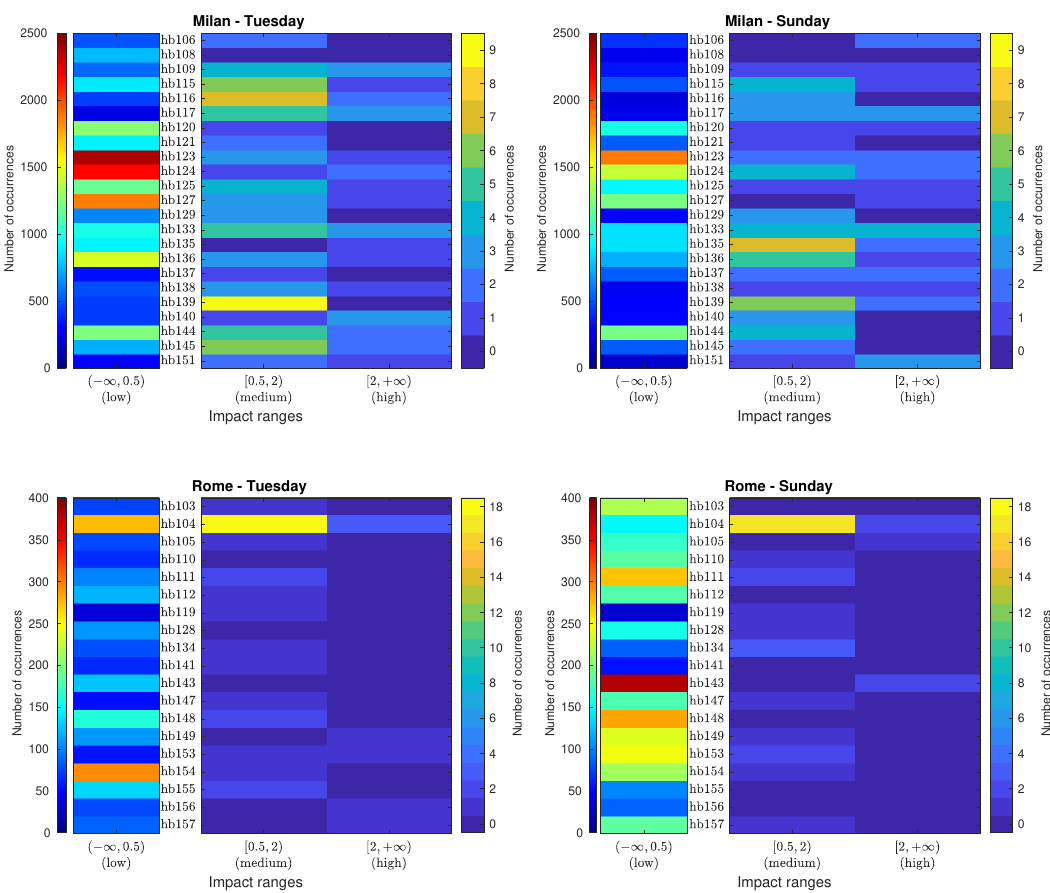
Figure 3. Individual impact histogram matrices (obtained using integration time T = 300 s) categorized in three impact ranges (low, medium and high) for the urban (Milan) and suburban (Rome) environments obtained from a weekday (Tuesday) and weekend day